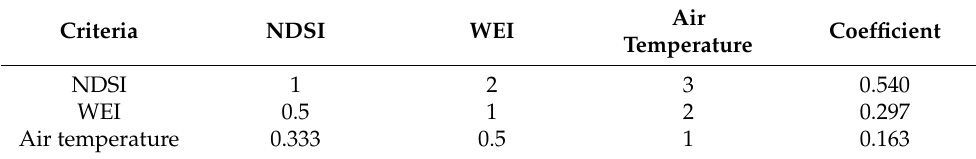
Table 5. Matrix of climatological subindicators.